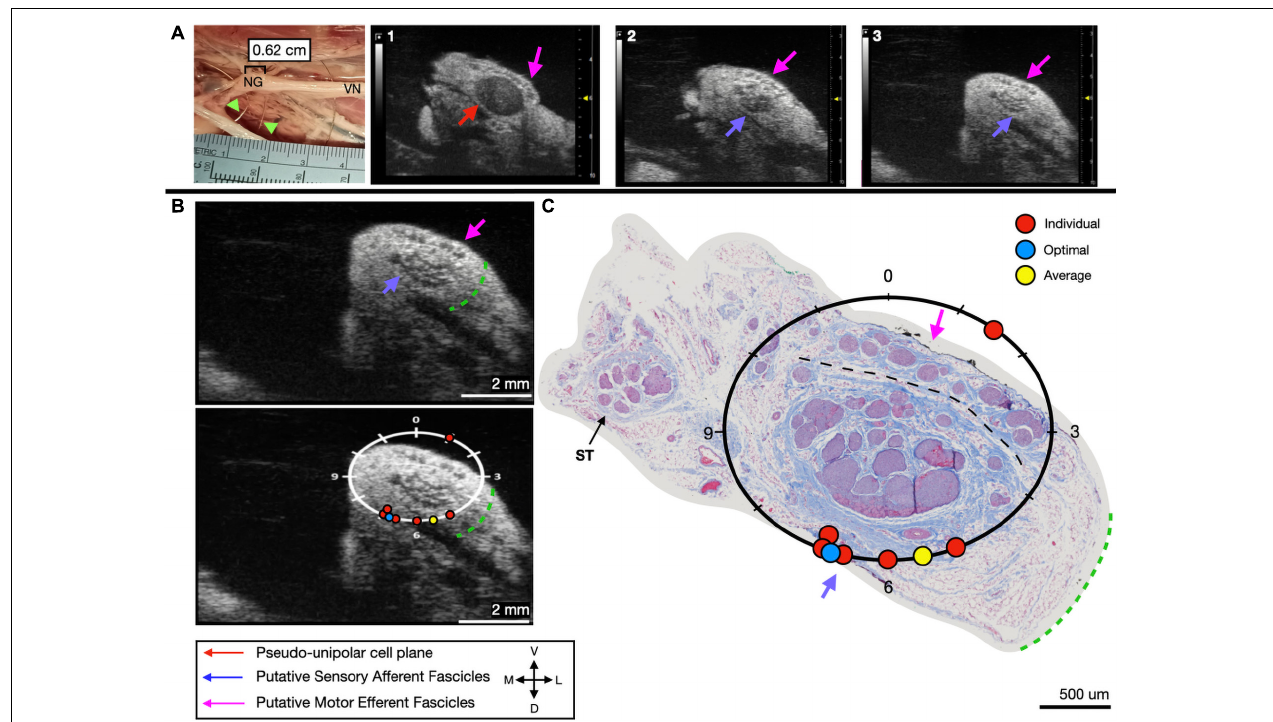
FIGURE 5 | Subject 1 (A) From Left to Right: Location of wire fiducials within the surgical pocket. (Note, this subject’s surgical photo does not contain histology dye, however, it was placed on the nerve before removal from the pocket). The location of the paired ultrasound video and required placement of stimulating contact is at wire fiducial two [0.62 cm from the superior laryngeal coming off of the nodose ganglion (NG)]. (A1–3) Progressive ultrasound images in the cranial to caudal direction from the NG to the cervical vagus nerve (VN), and location where volunteers were requested to place the stimulating contact (1–3, respectively). Red arrow indicates pseudo-unipolar cell region of the NG, pink arrows indicate motor efferent region, purple arrow indicates sensory afferent region, as confirmed via histology. (B) Ultrasound cross sections of wire fiducial two, where volunteers were asked to trace the sensory afferent axons from the NG. Top panel: pink arrows note motor efferent region, purple arrow indicates the sensory afferent fascicle grouping, green dashed line indicates area of transected connective tissue during removal for histology. Bottom panel: analog clock face placed on test video to give volunteers locations to place the hypothetical stimulating contact based on their tracing task, green dashed line indicates area of transected connective tissue during removal for histology. (C) Histology slice from wire fiducial two, as indicated with histology dye, with analog clock face to demonstrate stimulating contact locations as placed by volunteers in the ultrasound video. Green dashed line indicates area of transected connective tissue during removal for histology. (B,C) Red circles indicate each volunteer’s placement of the stimulating contact, the yellow circle indicates the average response, and the blue circle indicates the optimal contact location. Sympathetic trunk (ST), medial (M), ventral (V), dorsal (D), lateral